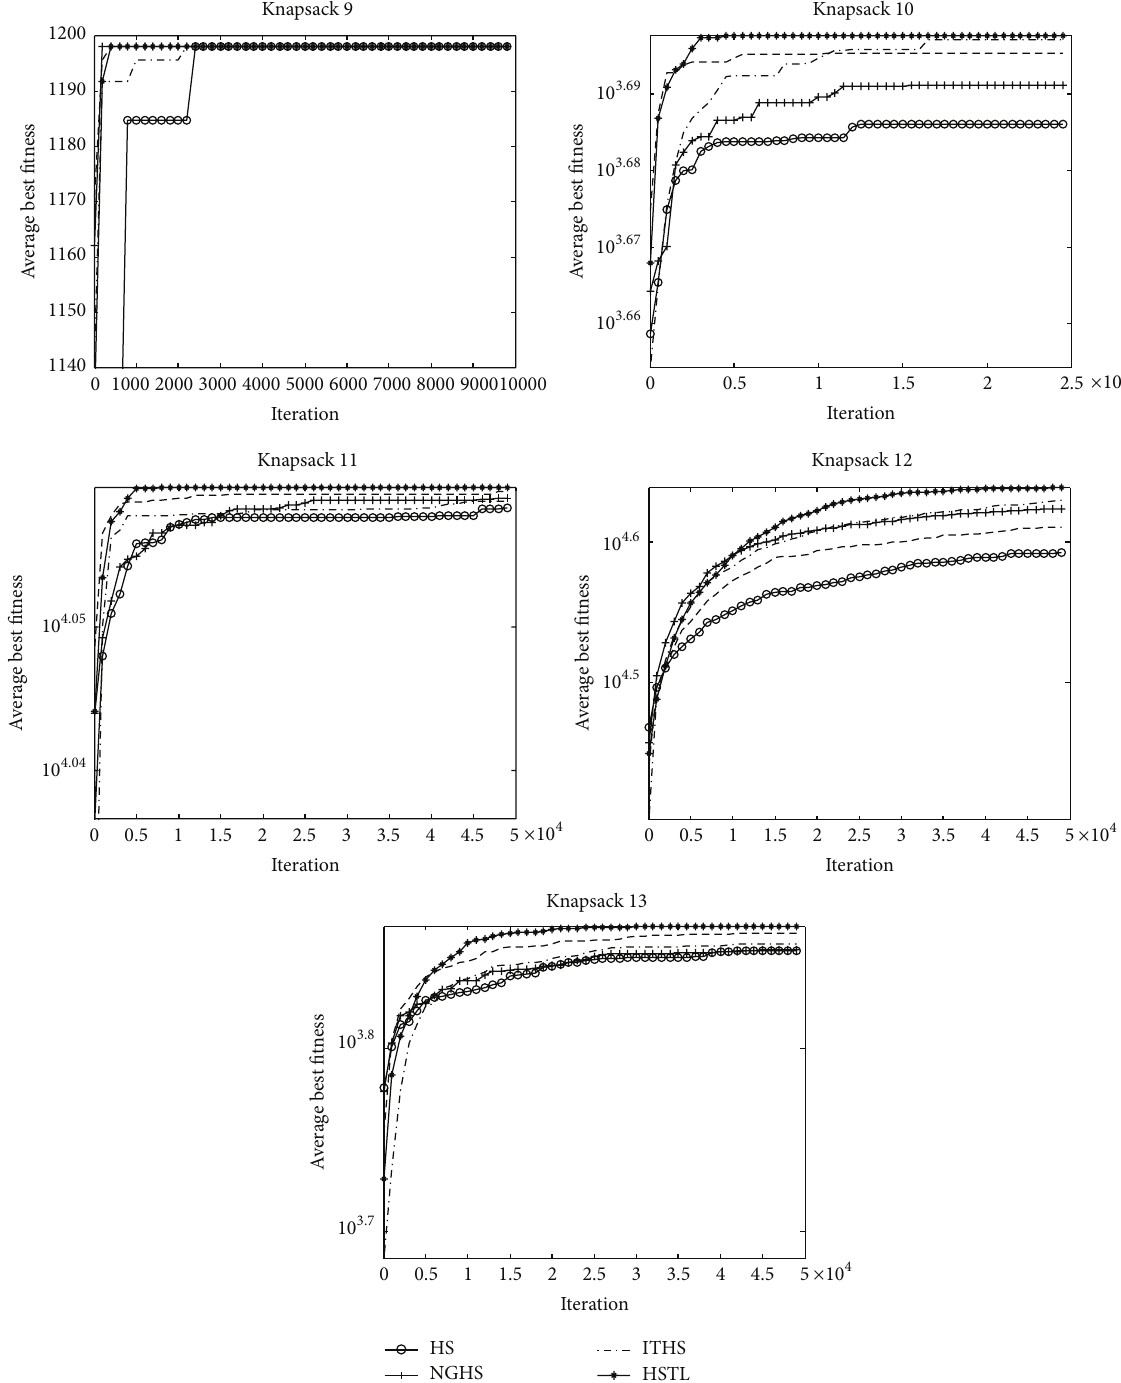
Figure 8: The convergence graphs of KP 9 –KP 13